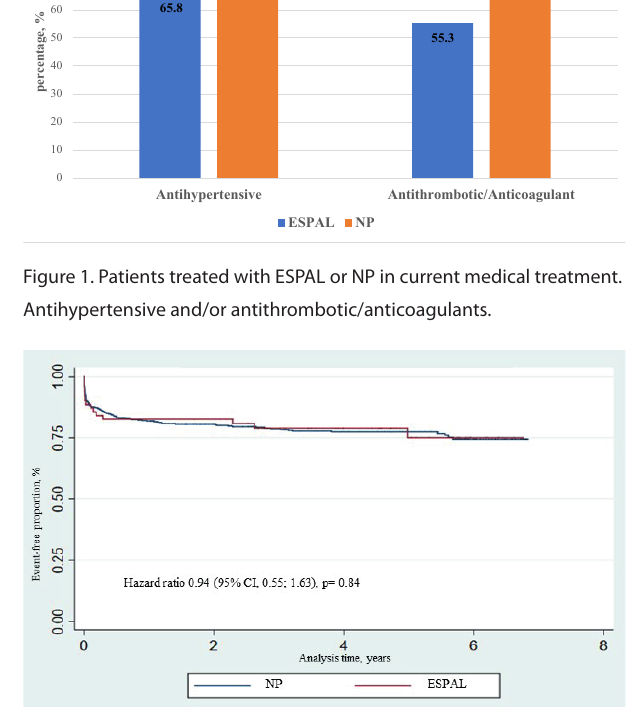
Figure 2. Kaplan-Meier plot of re-admission to hospita! after treatment with NP or